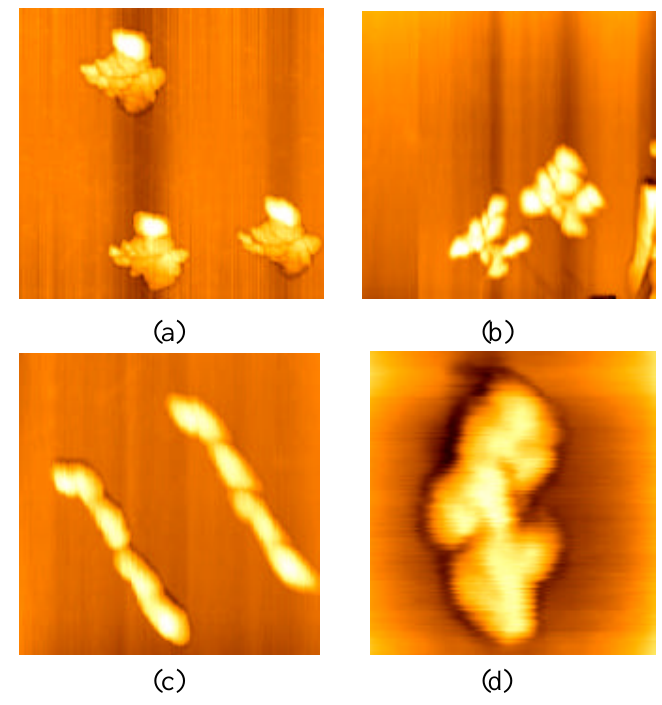
Figure 4. Shapes of polymer self-assembled by several monomolecules Scanning scopes: a. 2µm; b. 800nm; c. 600nm; d.